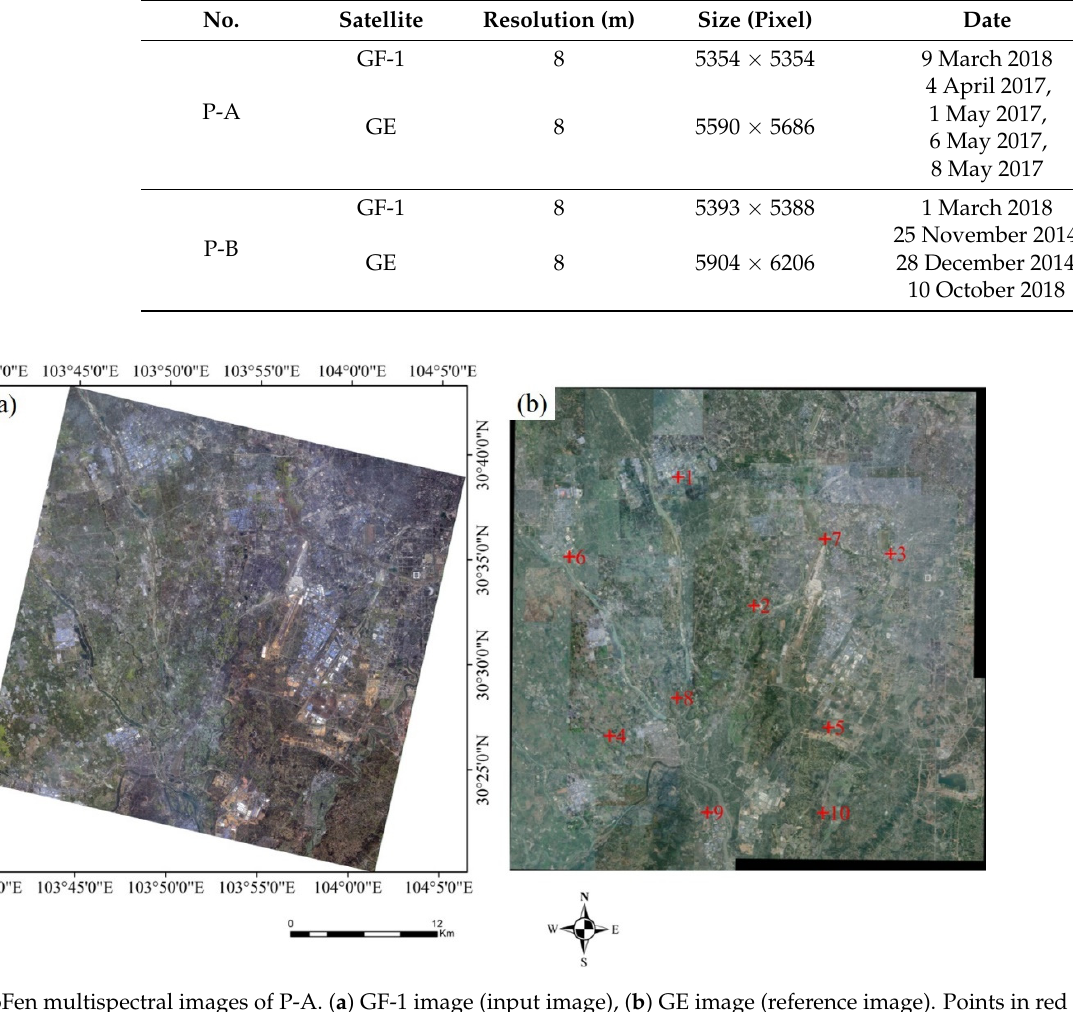
Figure 5. GaoFen multispectral images of P-B. ( a ) GF-1 image (input image), ( b ) GE image (reference image). Points in red are verification points.